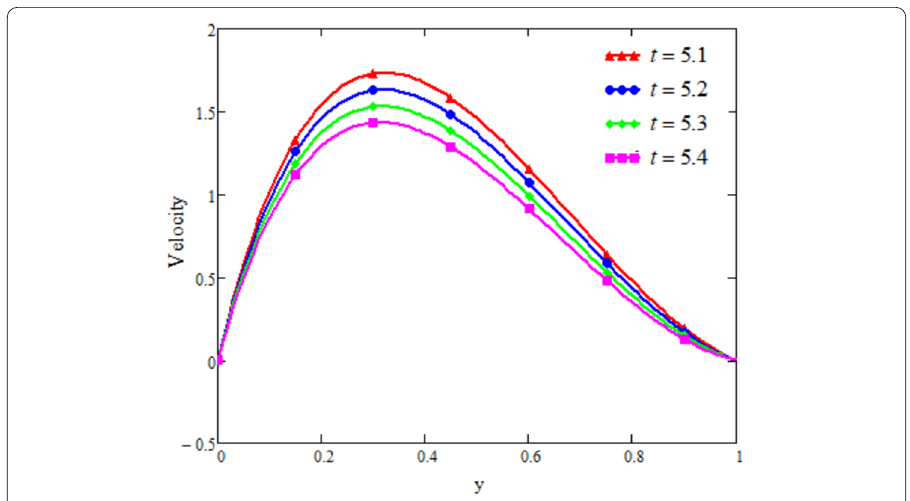
Figure 12 Velocity curves along t variation and α = 0.5, P r = 15, G r = 15.5, K = 12.5, λ = 1.9, λ 1 = 1.6, H a = 0.8, t =